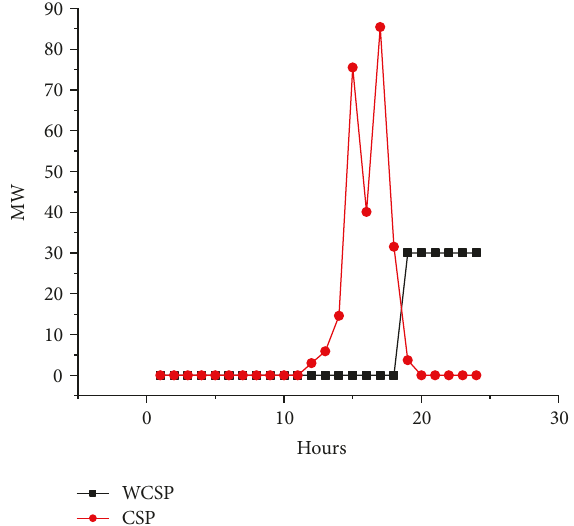
CSP system and the actual power generation on Equinox Day.